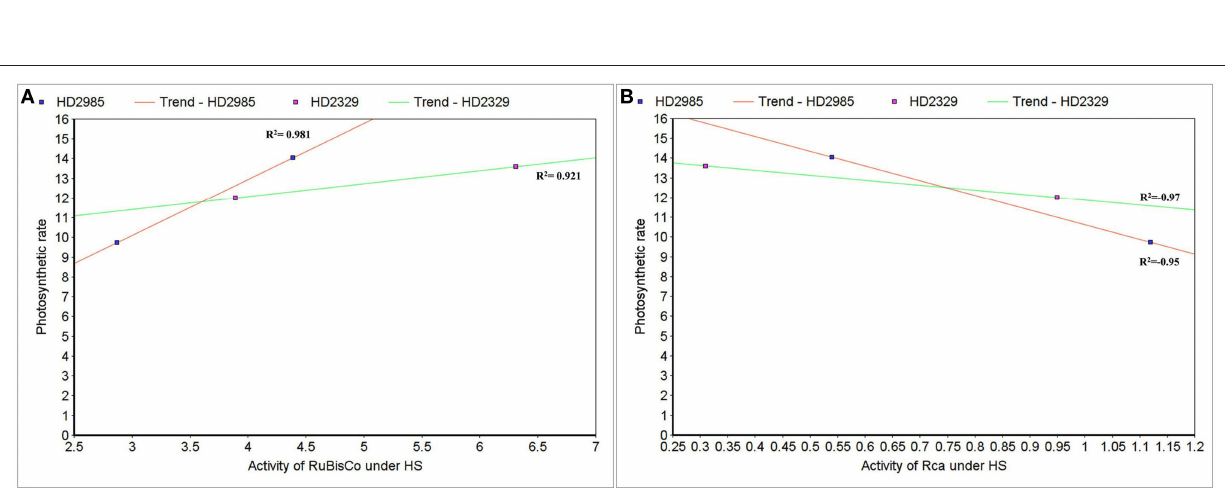
FIGURE 13 | Correlating the activity of RuBisCo activase (Rca) and RuBisCo with photosynthetic rate in wheat under the heat stress. (A) Cluster-map analysis of RuBisCo activity with photosynthetic rate in HD2985 and HD2329 under HS, (B) Cluster-map analysis of Rca activity with photosynthetic rate in HD2985 and HD2329 under